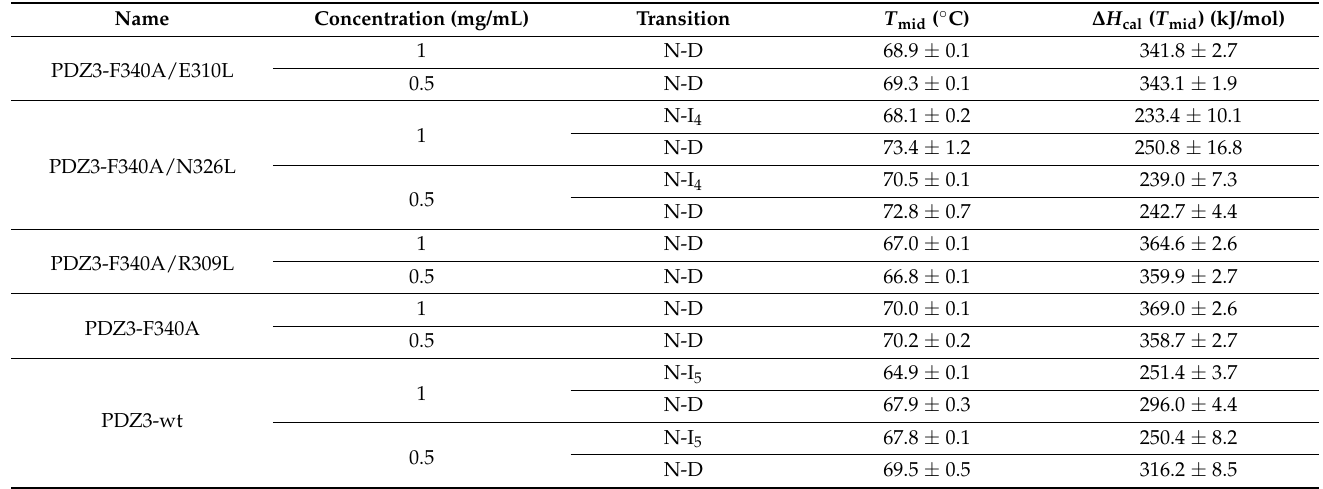
Table 3. Thermodynamics parameters were calculated by DSC measurements at 0.5–1 mg/mL of protein